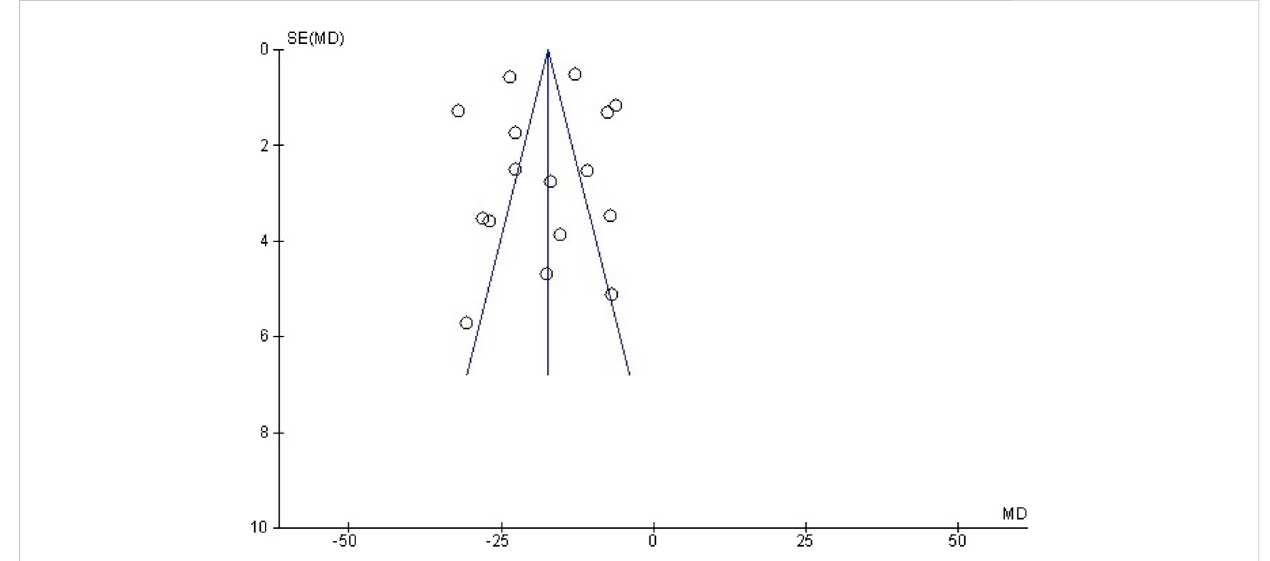
Funnel plot detailing publication bias in animal studies reporting the effect of curcumin on MI